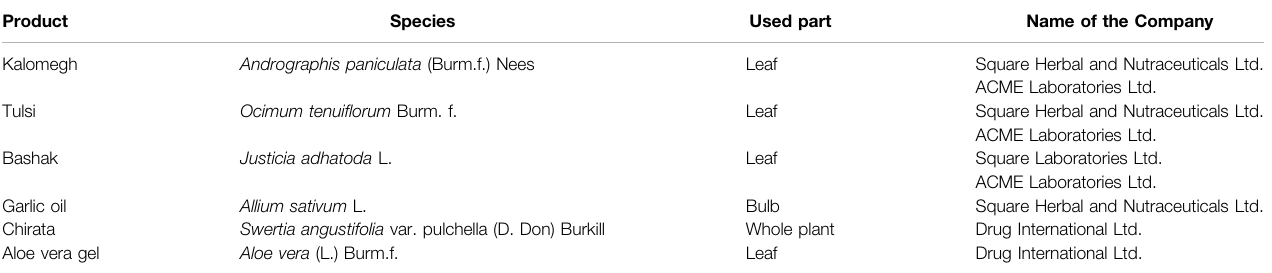
TABLE 4 | Available commercial herbal preparations from antiviral medicinal plants in Bangladesh